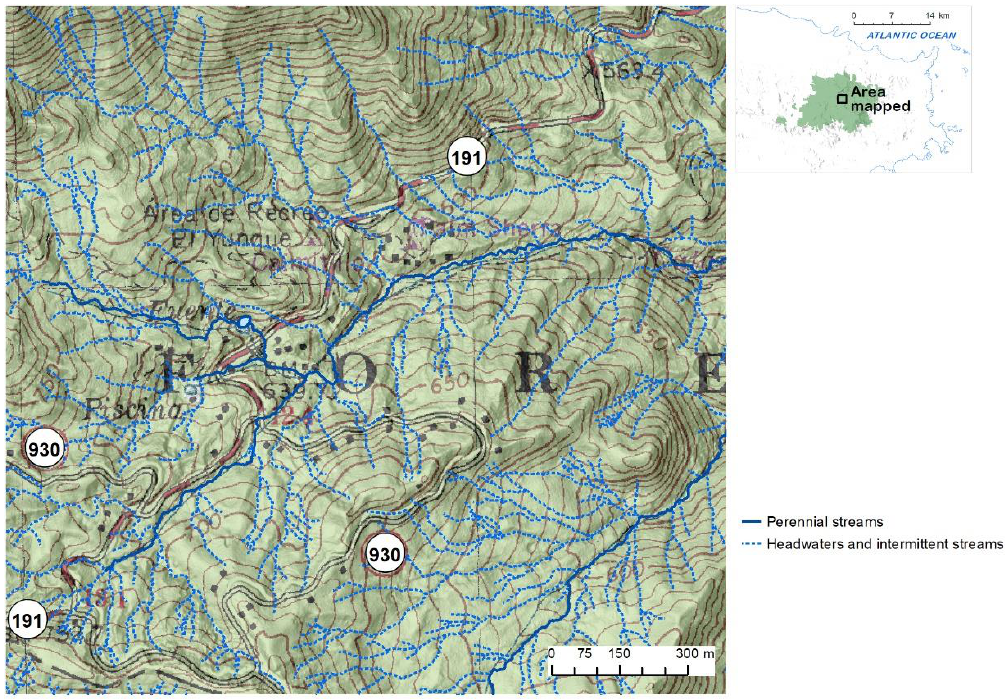
Figure 3. Detail of the derived surface model and the topographic map (panel a, top figure).